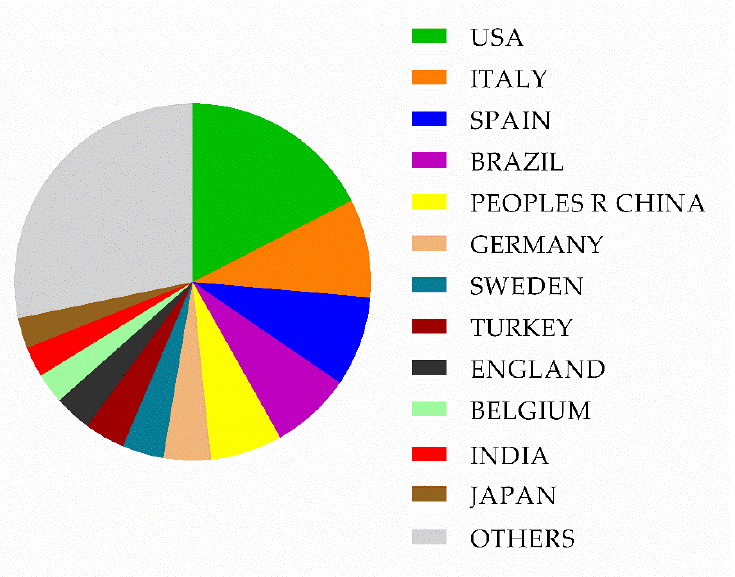
Figure 4. Distribution of cites per year. The distribution of cites per year from 1991 to 2020 shows a power law with a negative exponent (R 2 = 0.721), in keeping with the Bradford law, demonstrating the rising interest in this field of study.